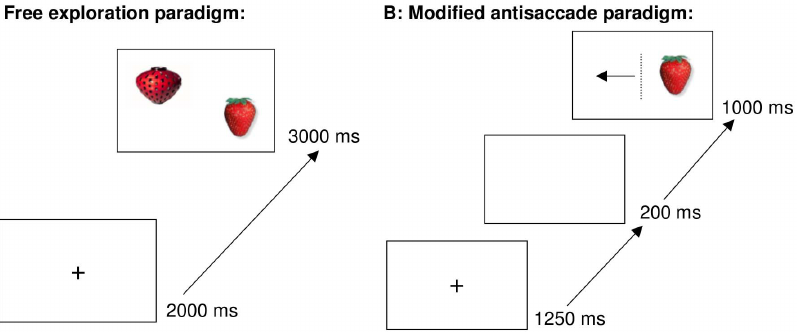
Figure 1. Schematic presentation of the free exploration paradigm (A) and the modified antisaccade paradigm (B). Panel A: Each of the two stimuli (food vs. nonfood) had a height of 8.2 cm and a width of 12 cm and were located with the midmost corner 0.8 cm away from the centre of the screen. The position of the stimuli (upper vs. lower and left vs. right quadrant) was balanced. Panel B: The stimuli (food or nonfood) had a height of 8.7 cm and a width of 11.8 cm and were located 3.5 cm from the centre of the screen. The position of the stimuli (left vs. right) was randomised.